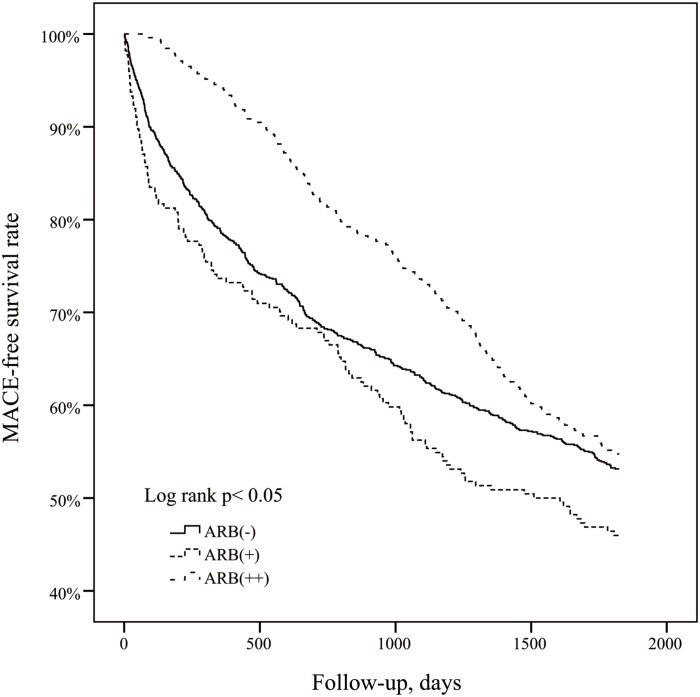
The Kaplan-Meier curve of the MACE-free rate.